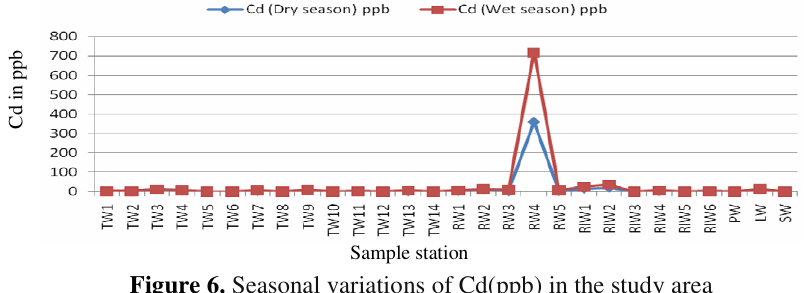
Figure 6. Seasonal variations of Cd(ppb) in the study area